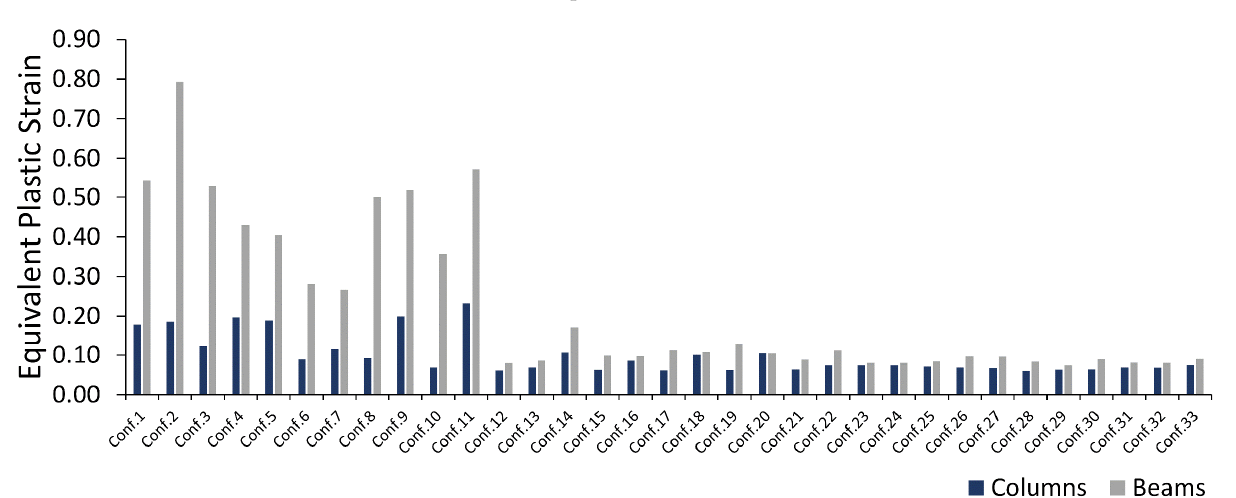
Figure 6. Settlement at the top of the structure.